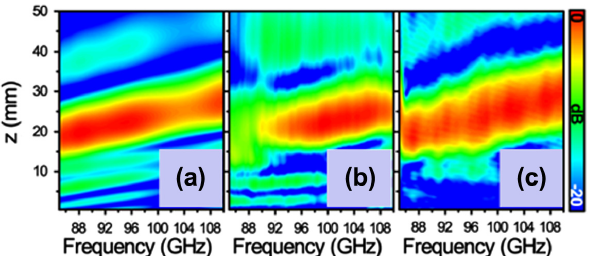
Figure 2. Normalized power distribution along z axis for the frequency range 85–110 GHz: (a) analytical results, (b) simulation and (c) experimental results.